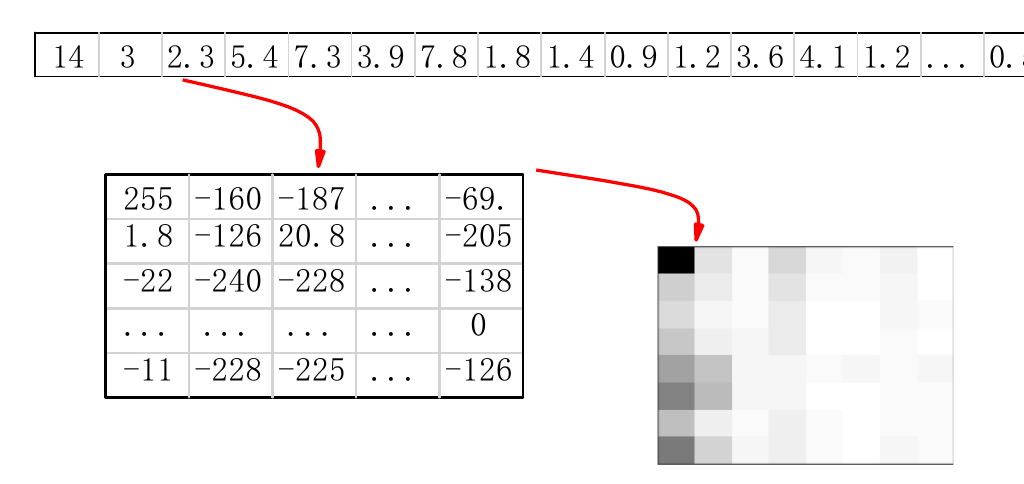
Figure 1. Data-to-image conversion method.